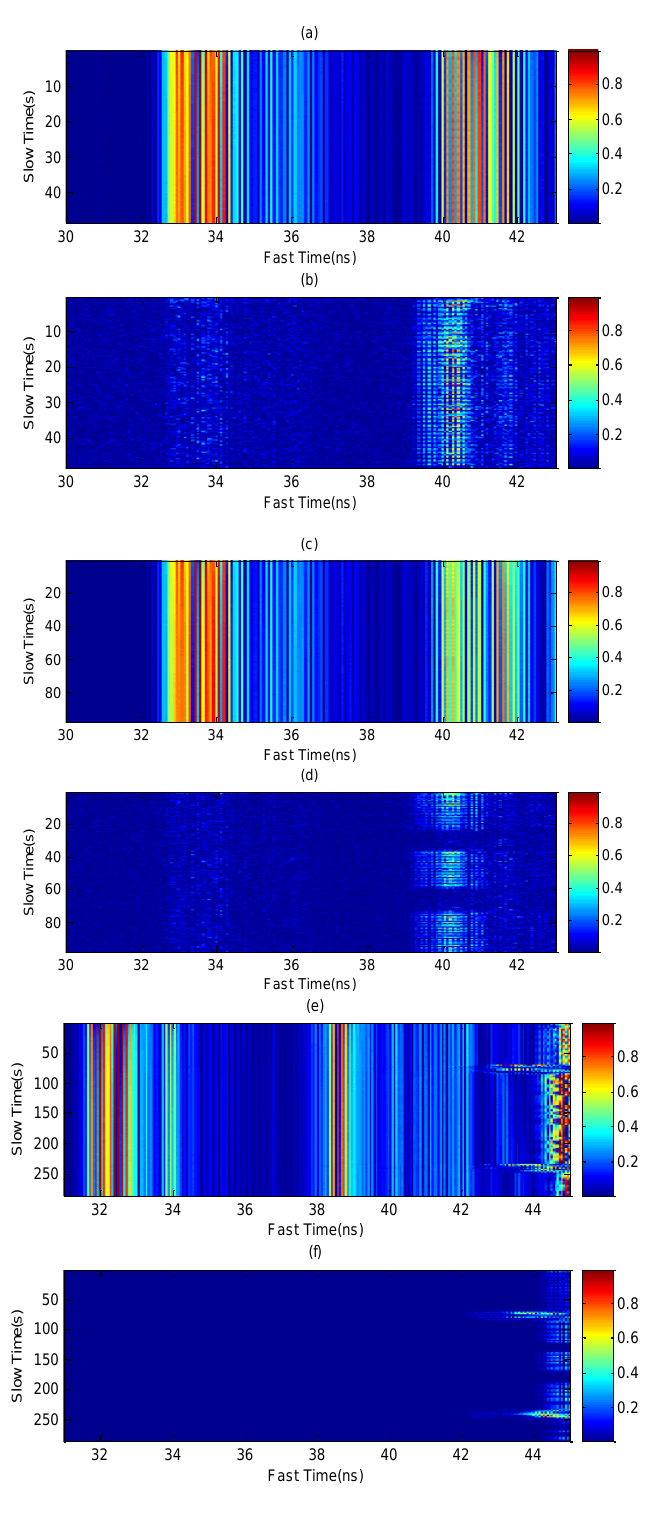
Figure 6. Raw Data and Data after clutter removing algorithm. ( a ) and ( b ) are from the case of a subject with continuous breathing, ( c ) and ( d ) are from the case of a subject with simulated periods of apnoea, and ( e ) and ( f ) are from the case of a subject with simulated periods of apnoea and random body